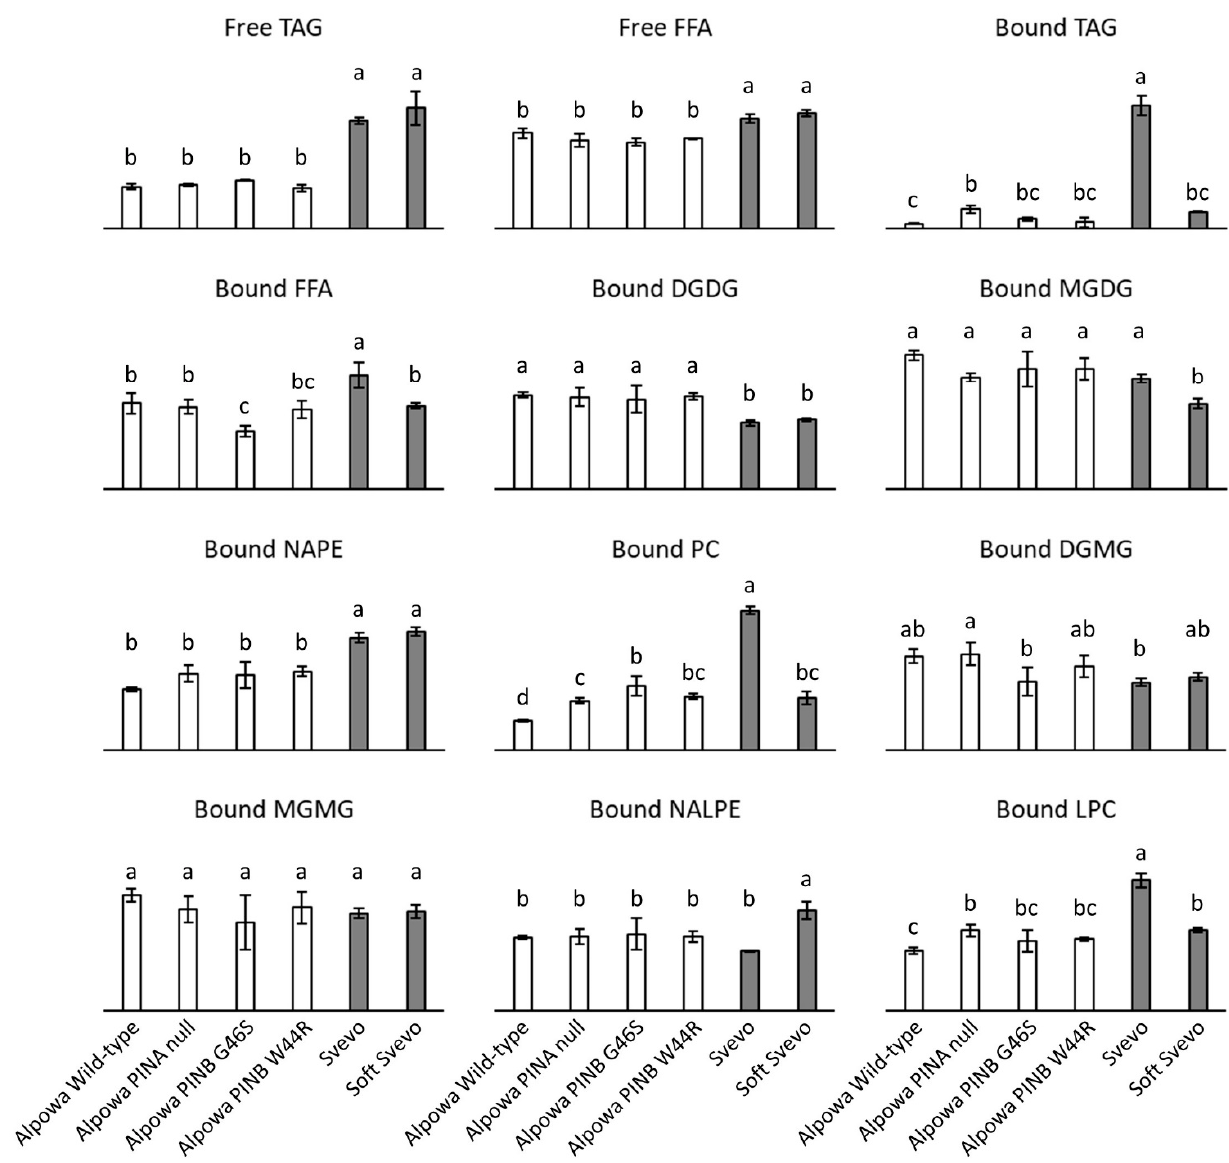
Figure 3. Lipid composition of flours from near-isogenic wheat lines. Lipid levels are presented as the area under the curve relative to the area under the curve of the internal standard. Free and bound non-starch lipids were sequentially extracted with hexane and water-saturated butan-1-ol, respectively. Averages with corresponding standard deviations of triplicate measurements are shown. For each lipid class, bars with differing letters are significantly different from each other ( p < 0.05). TAG, triacylglycerols; FFA, free fatty acids; DGDG, digalactosyldiacylglycerols; MGDG, monogalactosyldiacylglycerols; NAPE, N-acyl phosphatidylethanolamines; PC, phosphatidylcholines; DGMG, digalactosylmonoacylglycerols; MGMG, monogalactosylmonoacylglycerols; NALPE, N-acyl lysophosphatidylethanolamines; LPC, lysophosphatidylcholines.